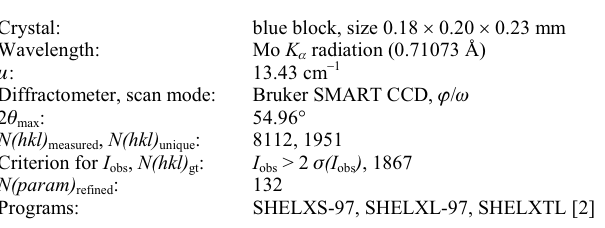
Table 1. Data collection and handling.